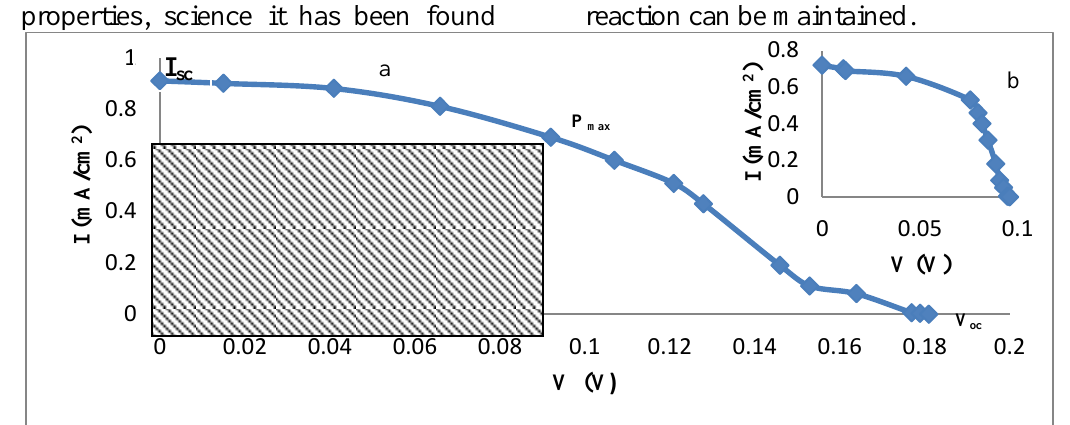
Fig. 3: Maximum output power for a-Cu